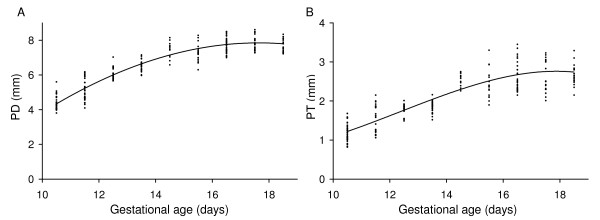
Placental growth quantified using ultrasound parameters. Relationship between (A) placental diameter (PD) and (B) placental thickness (PT). The lines were generated using the regression equation between the parameter and gestational age shown in Table 1. The regression equations were derived using the datapoints shown (each point is the result obtained in one conceptus).